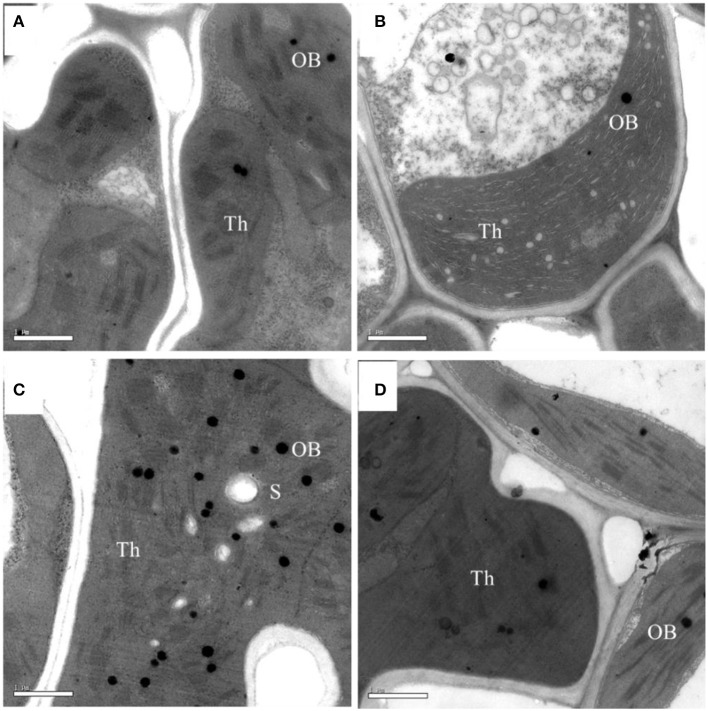
Electron micrographs of chloroplasts under low (LL; A,B) and high light treatment (HL; C,D) in Z802 (A,C) and pgl
(B,D). Bars = 1 μm. Th, thylakoid lamellae; OB, osmophilic body; S, starch.